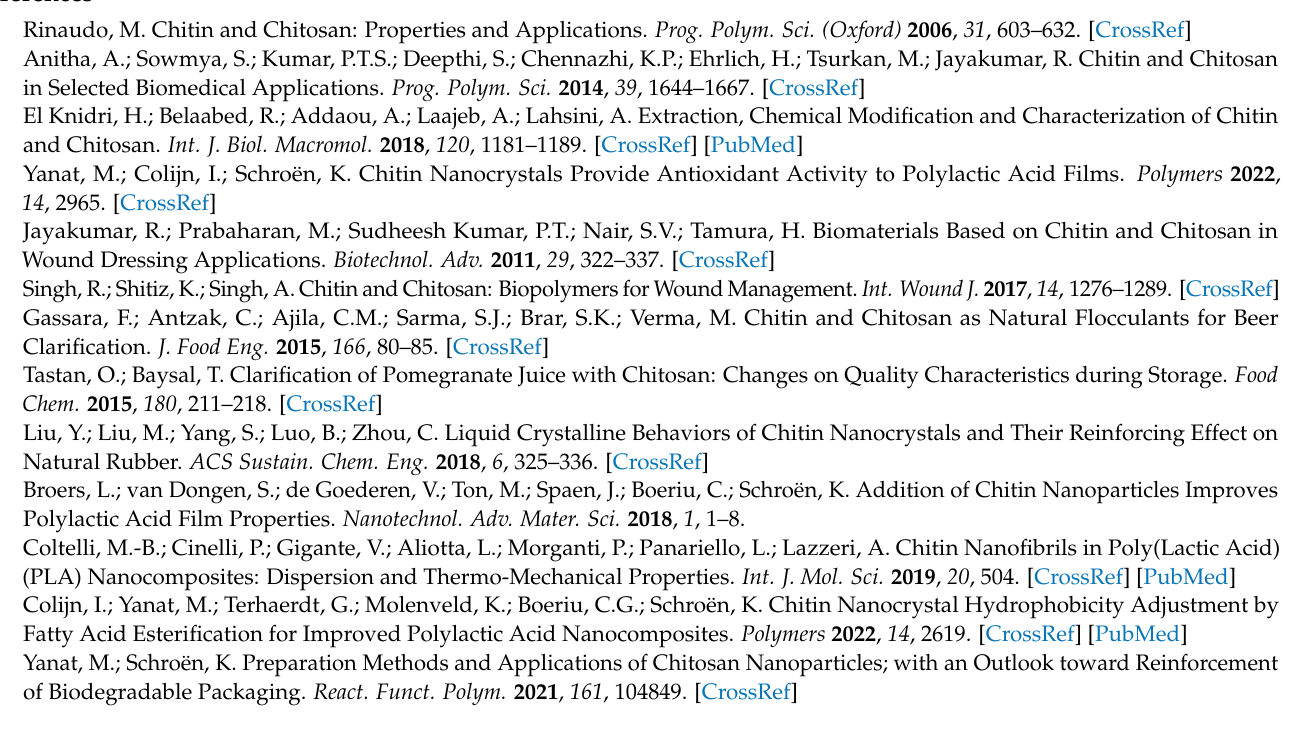
Figure A8. The UV-Vis spectra of samples after 24 h incubation at 55 °C. ( A ) chitin powder, ( B ) chitosan powder, ( C ) chitin nanocrystals (ChNC), ( D ) deacetylated chitin nanocrystals (D-ChNC).